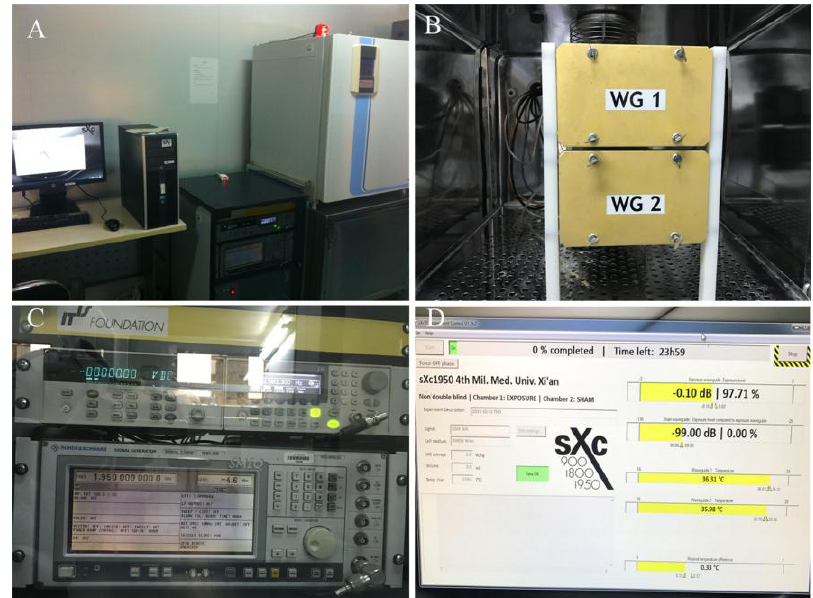
Figure 1. 1950 MHz radiofrequency (RF) exposure system. ( A )Exposure setup; ( B ) Mu-metal box; ( C ) Current source; and, ( D ) Arbitrary function generator controlled by a computer.